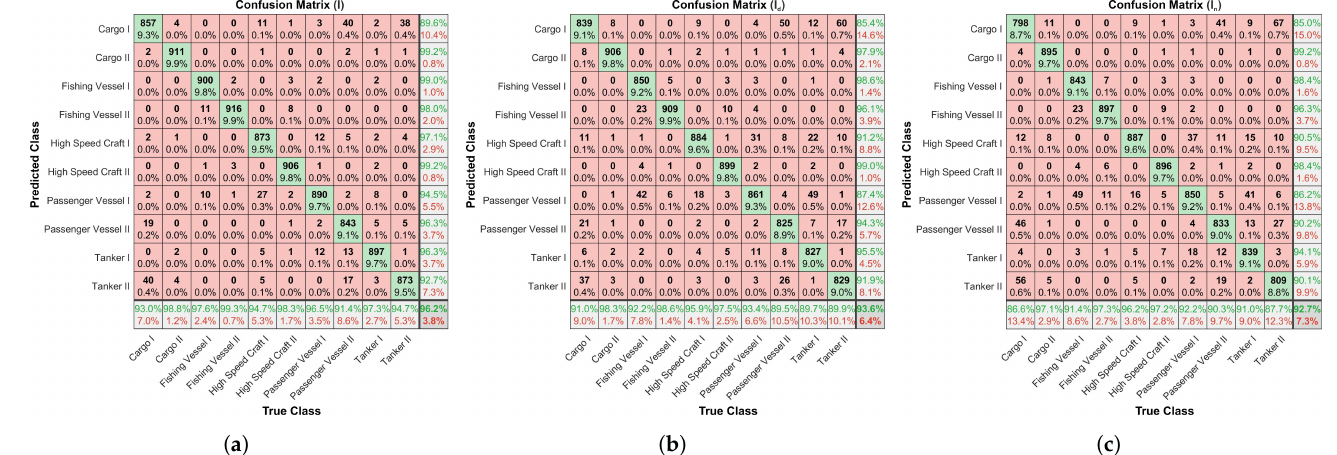
Figure 4. Confusion matrices for classification performance on test sets by trained CNNs for the paired ‘network-dataset’: ( a ) I -Net: I , ( b ) I d -Net: I d , ( c ) I n -Net: I n . Diagonal cells correspond to correctly classified